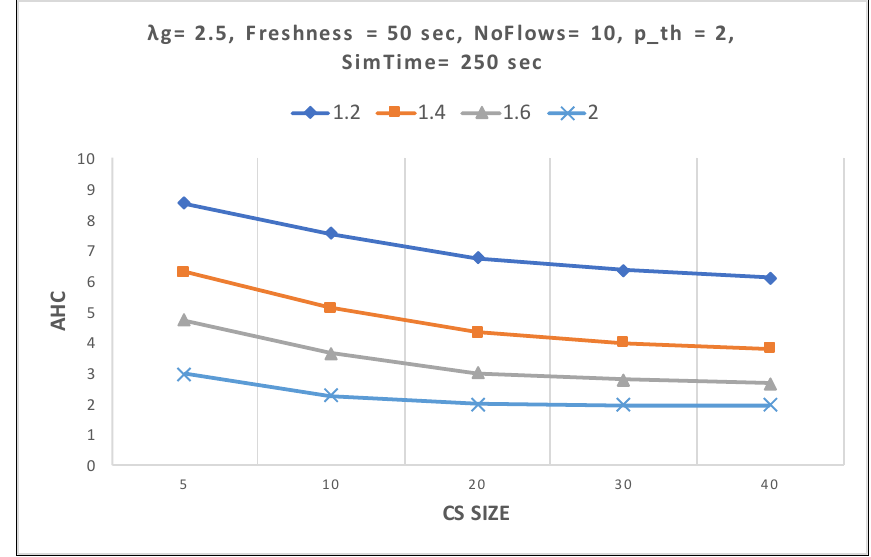
Figure 8. Average hop count to retrieve popular content as a function of CS